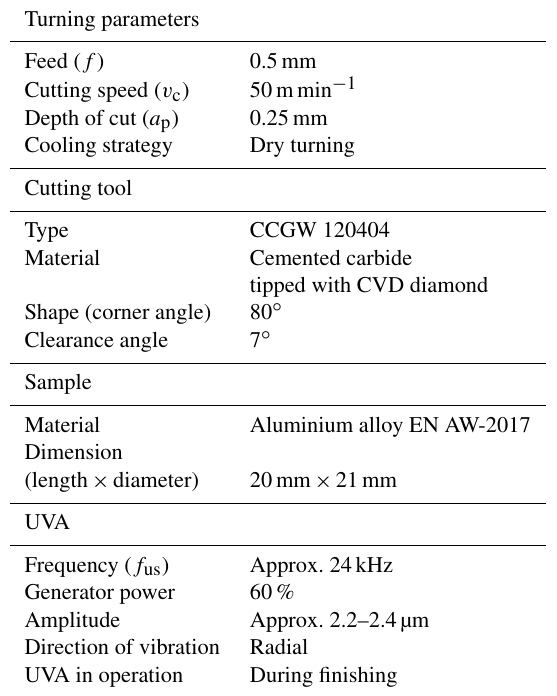
Figure 3. A detailed schematic illustration showing the main com- ponents of the ultrasonic (US) vibration-assisted system used in the experiments and the positions of the six strain gauges (SG) on the sonotrode. Except for SG 3 (violet) all strain gauges are on the rear side of the sonotrode (white with dashed frame). Table 1. Experiment parameters for the examined turning process. Turning